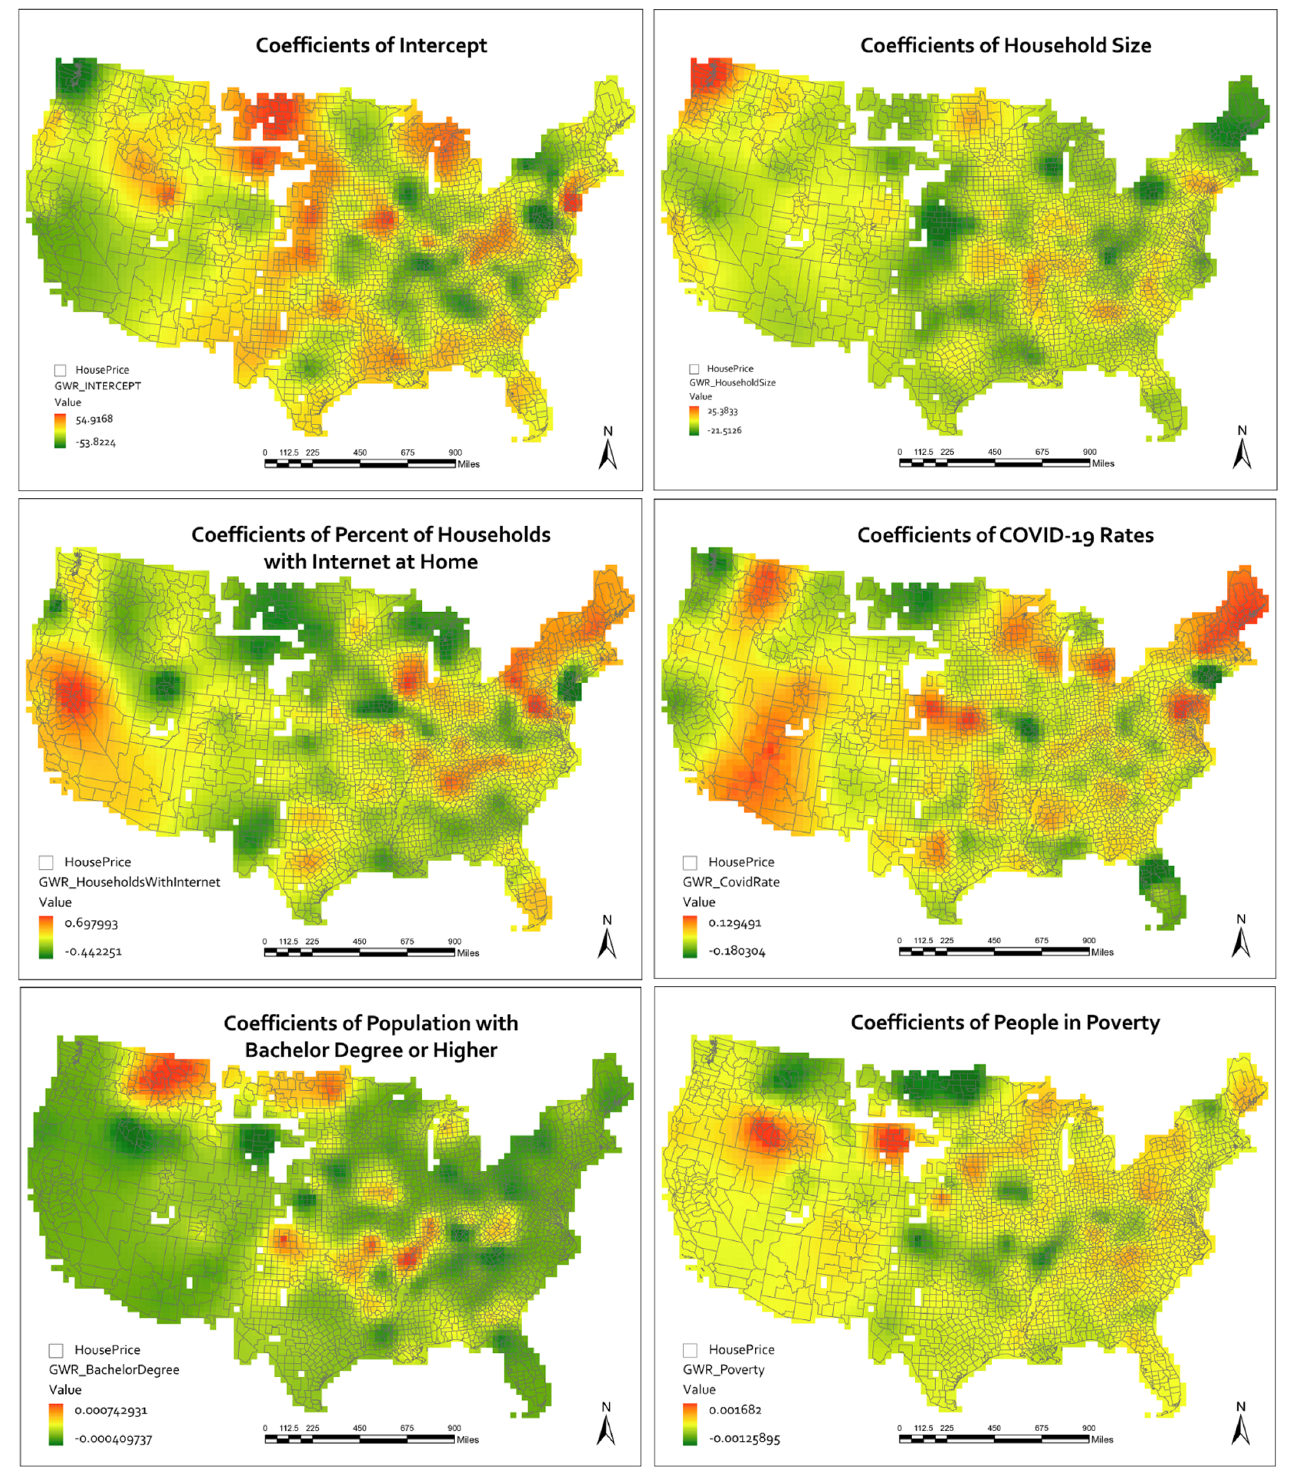
Figure 12. Local coefficient maps for explanatory variables in the GWR model. Local R-squared ( R 2 ) was used to explore the capability of the GWR model to fit the observation data. The high local R 2 values mean good performances. Figure 13 shows the local R 2 map of the GWR model. Obviously, the values of local R 2 change with spatial locations. It has a fairly small standardized deviation (0.131). The minimum local R 2 value is 0.048 and the maximum value is 0.94. Local R 2 values are higher than 0.80 in many